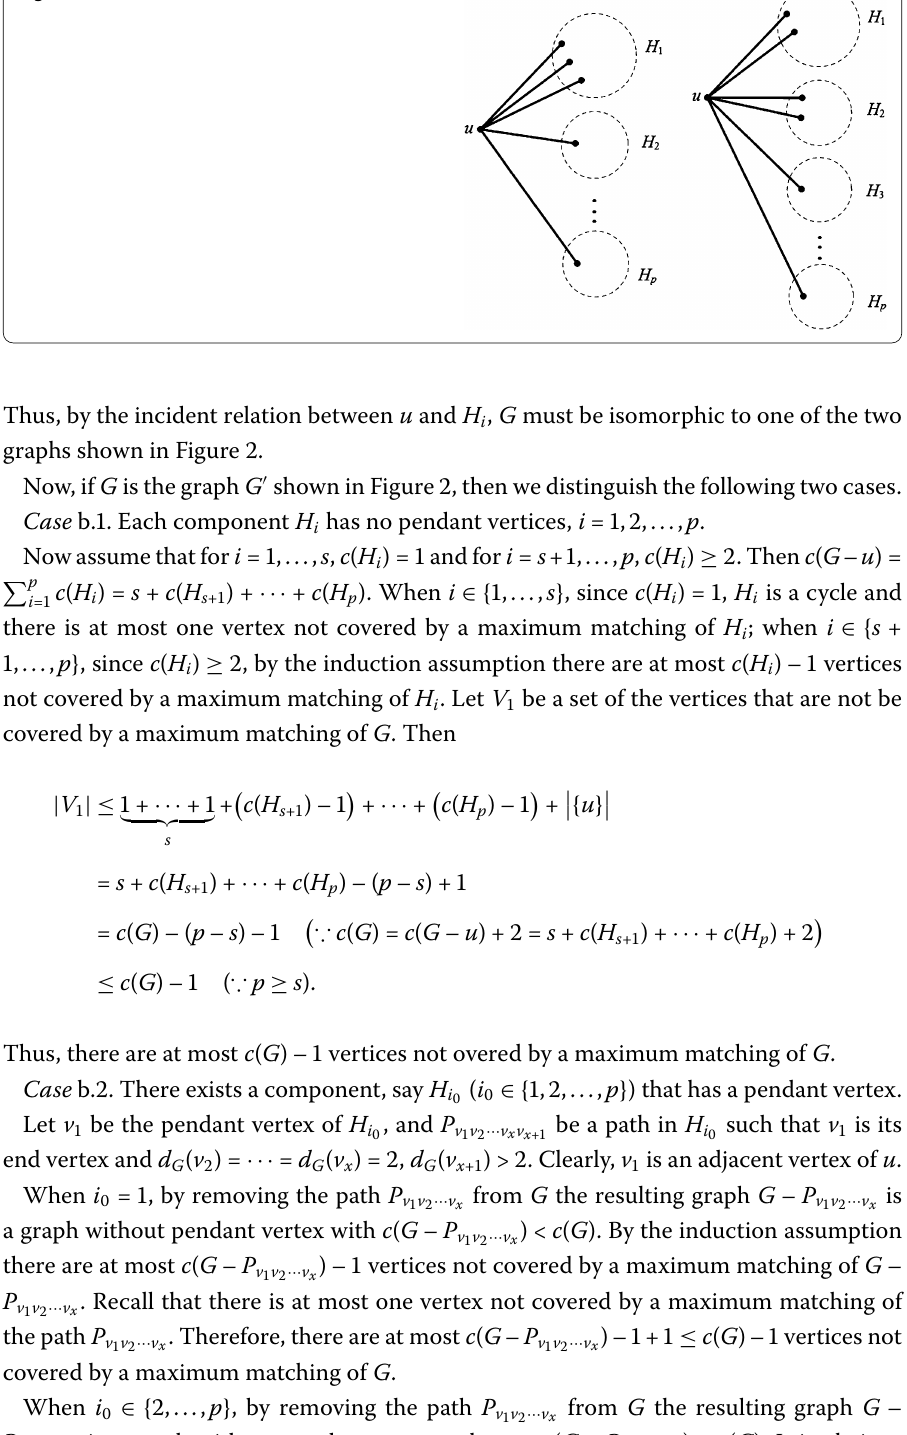
Figure 2 G (cid:2) and G (cid:2)(cid:2)